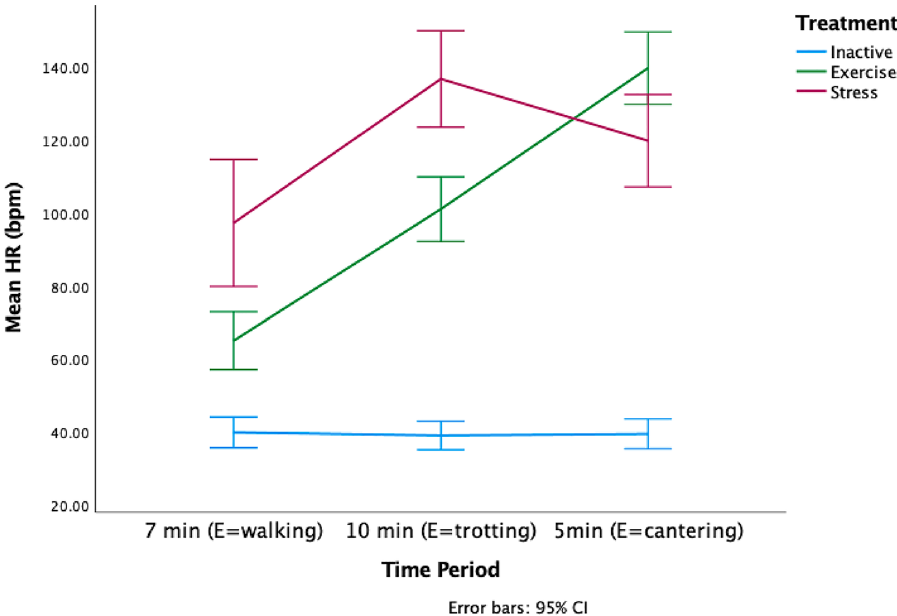
and the speed and duration of activity of the S horses varied throughout the treatment.